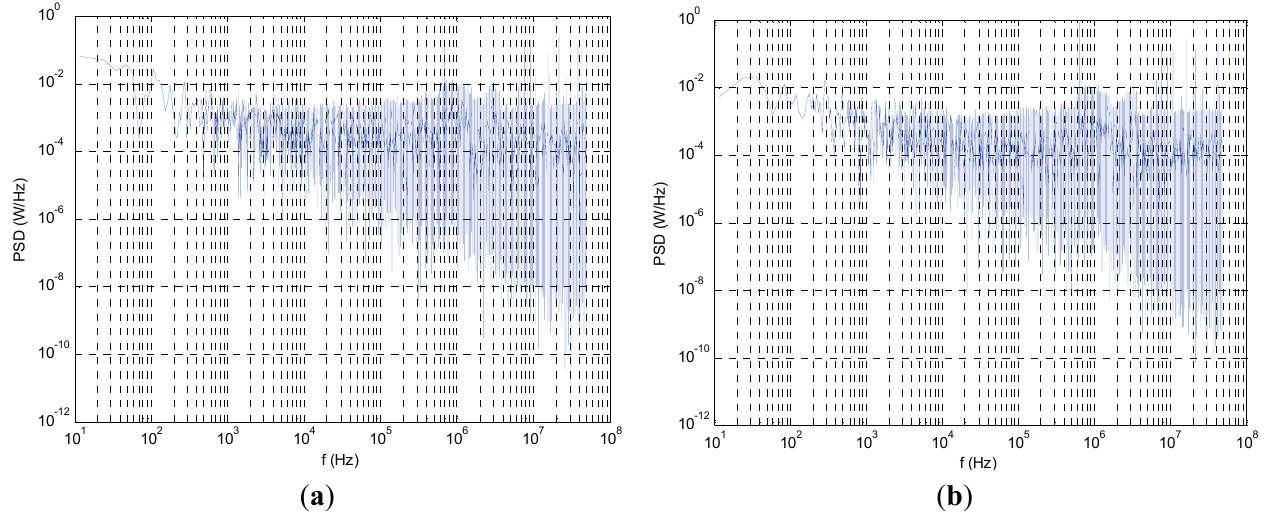
Figure 3. The power spectra of vacuum cleaner. ( a ) Normal; ( b ) Arc